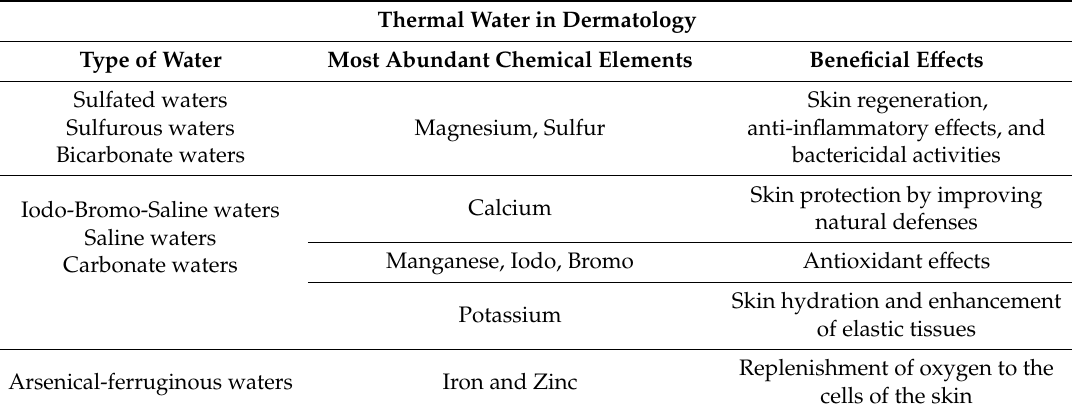
Table 2. Potential e ff ects on the skin of chemical elements present in thermal